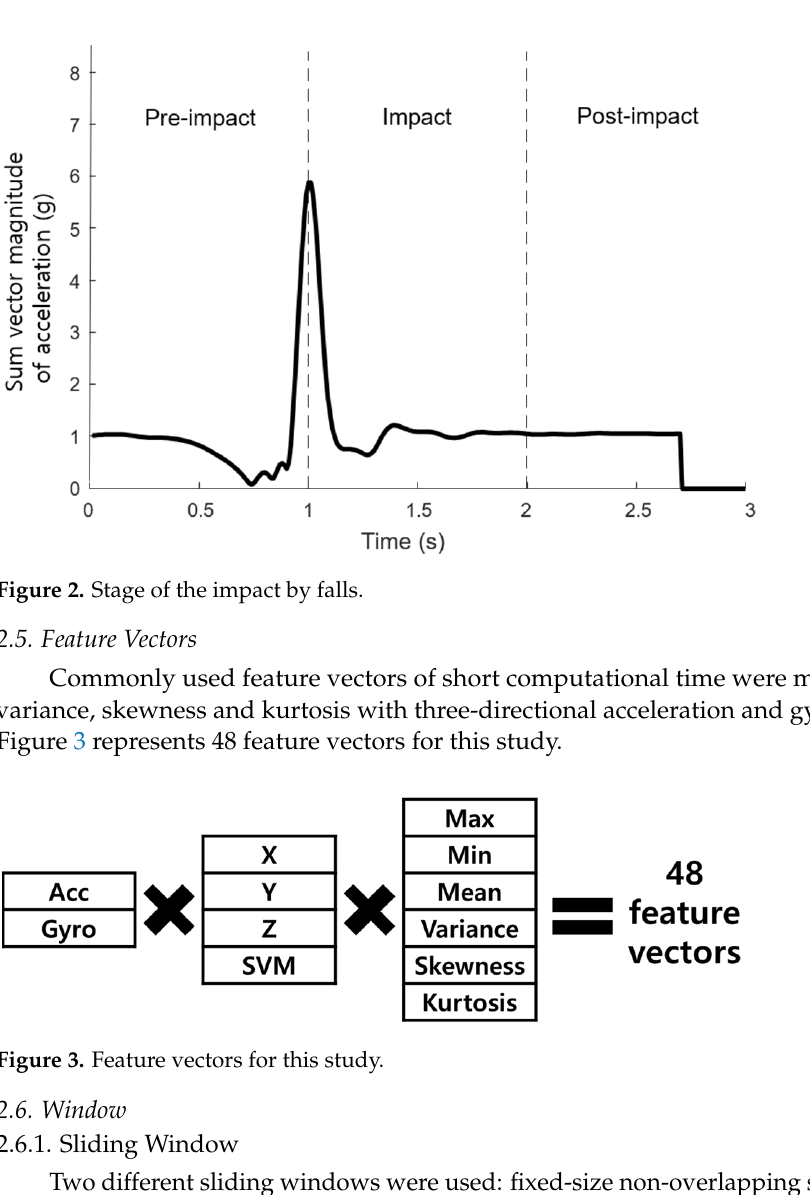
( b ) Figure 4. Sliding window: ( a ) FNSW and ( b ) FOSW. 2.6.2. Impact-Defined Window As shown in Figure 5, impact-defined window was determined from the peak value of the SMV of acceleration as the instant of the impact, and then extracted the forward and backward sub-windows based on the impact frame [25]. In this study, the total extracted number of frame was 300, in which backward sub-window size and the forward window size was 1 s and 2 s, respectively. The zero-padding technique was not used even if there were fewer than 300 frames. The impact-defined window feature (IDWF) was applied, in which 48 feature vectors in Figure 3 were extracted from these segmented data.